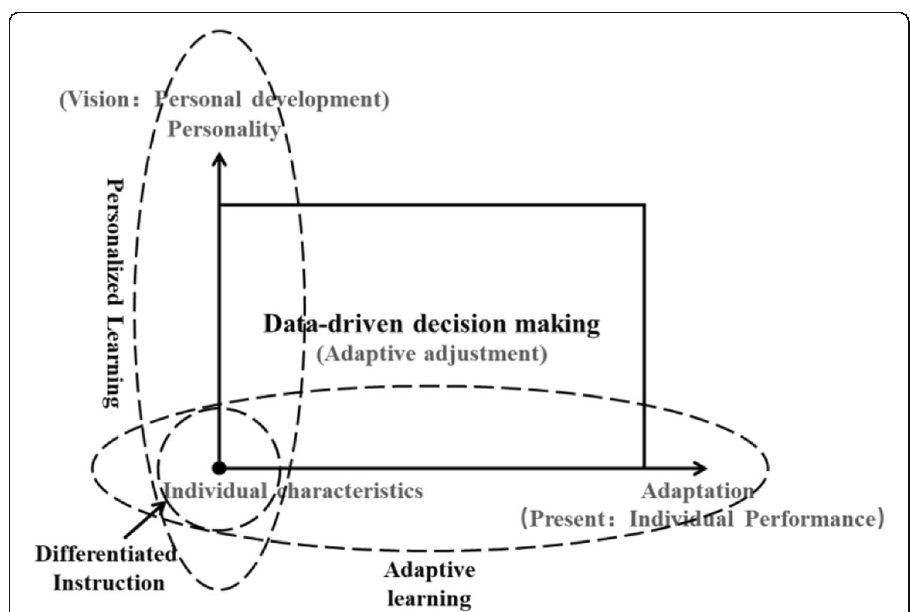
Fig. 2 Personalized adaptive learning